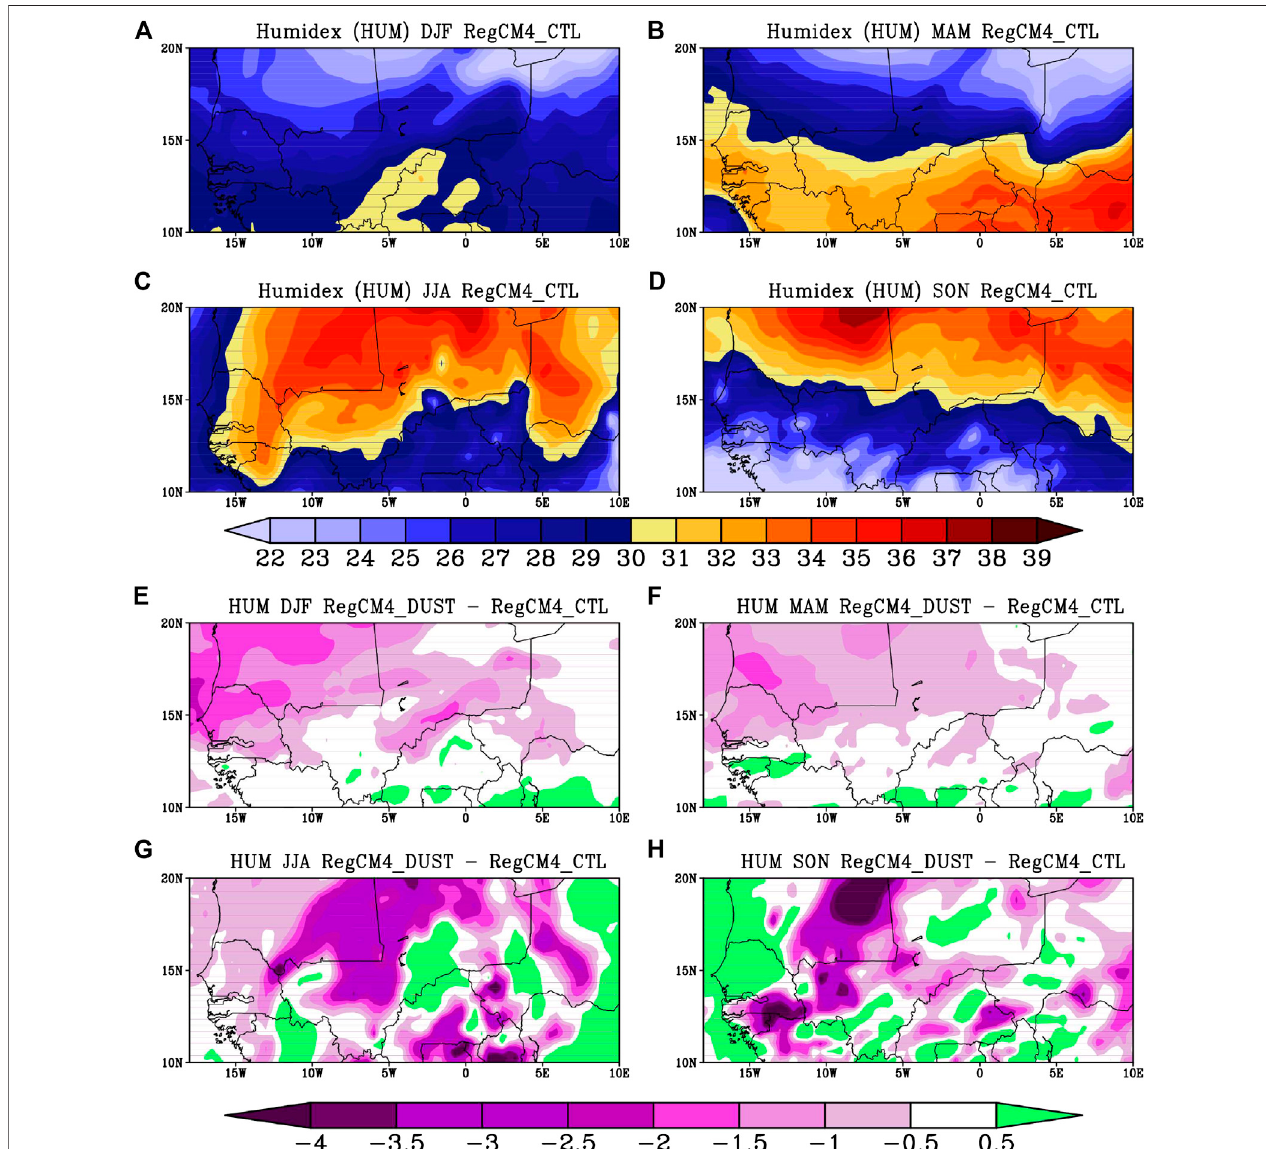
FIGURE11| Seasonalvariabilityofthehumidex( ° C)averagedfrom2001to2010overtheSahel: (top) RegCM4_CTL, (down) differencebetweenRegCM4_DUST and RegCM4_CTL. The differences are signi fi cant at 95% level using the Student test.